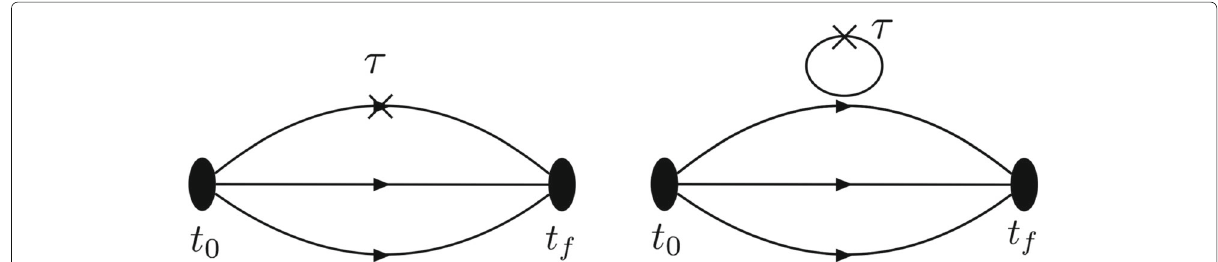
Fig. 1 Three-point function to obtain the nucleon matrix element. Left panel: quark skeleton diagram for the connected insertion (CI) where the current is inserted in the quark propagator between the source at t 0 and the sink at t f for the nucleon. Right panel: disconnected insertion (DI) where the current is inserted to the quark loop which gives the vacuum polarization contribution. The strange quark only contributes in the